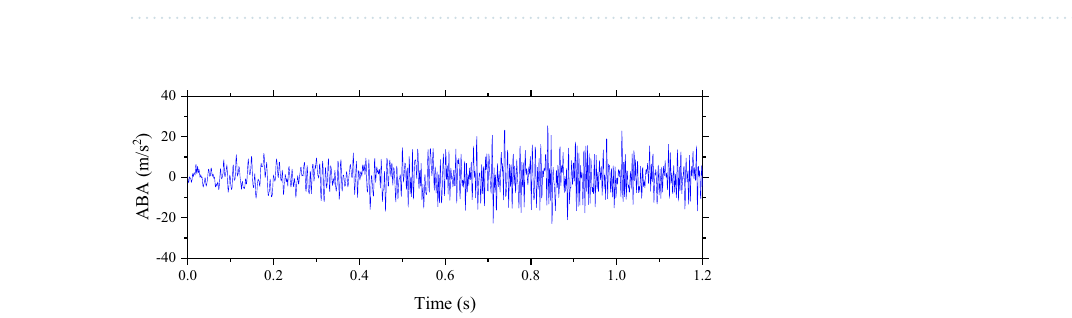
Table 2. Data variation of FEM simulations.